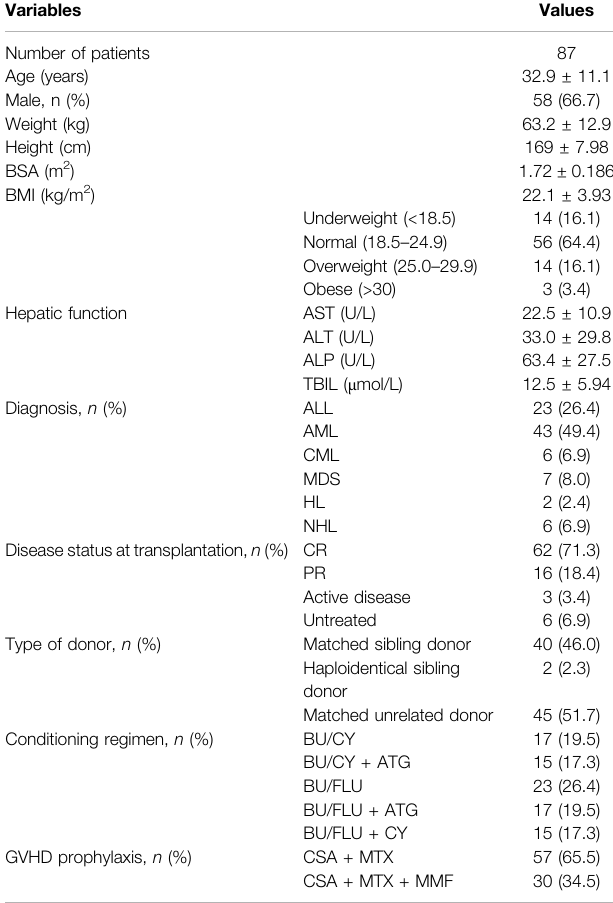
TABLE 1 | Demographic and baseline characteristics of the enrolled